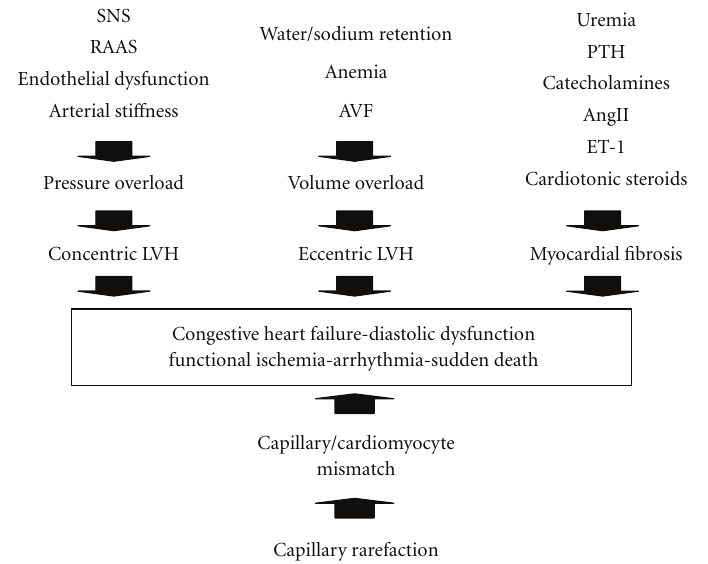
Figure 1: Heart alterations and their consequences in CKD. AVF: arteriovenous fistula, AngII: angiotensin II, ET-1: endothelin-1, LVH: left ventricular hypertrophy, PTH: parathormone, RAAS: renin-angiotensin-aldosterone system, SNS: sympathetic nervous